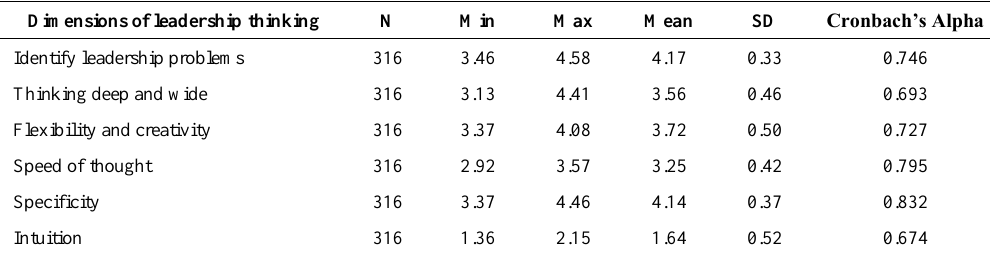
Table 6. The status of leadership thinking.